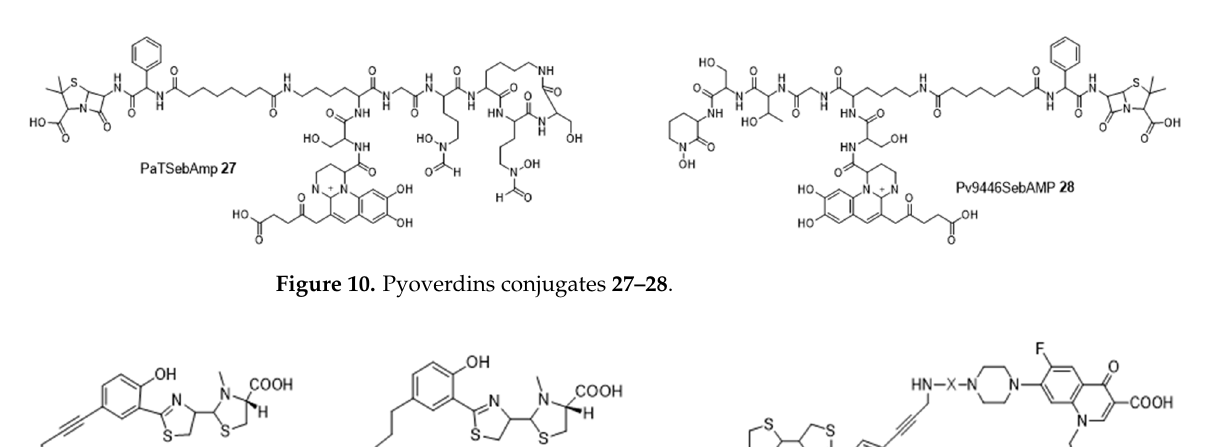
Figure 12 . Structure of cefiderocol 35 .